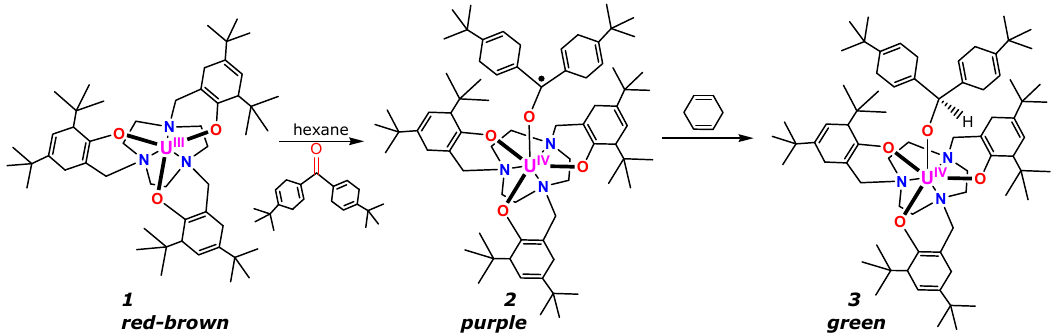
Figure 26. Formation of U(IV) benzophenone ketyl radical complex 2 through a one-electron reduction of 4,4 ′ -Di-tert-butylbenzophenone by U(III) precursor complex [((t-BuArO) 3 tacn)U III ] ( 1 ) followed by H abstraction to form a U(IV) diphenyl methoxide complex 3 [164].